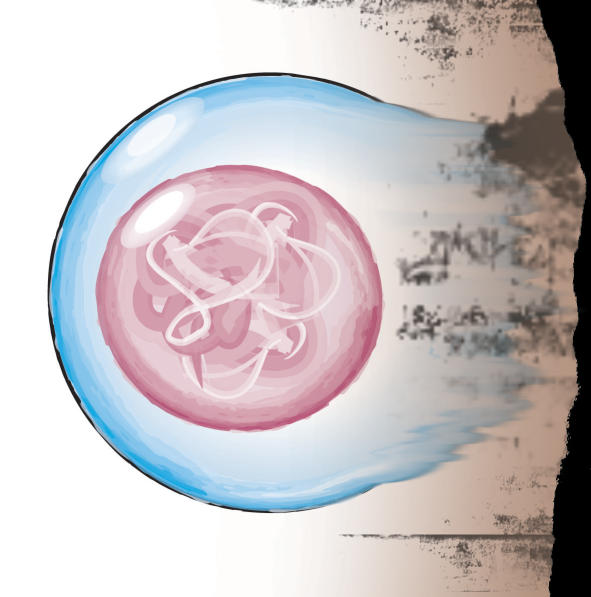
Aging HSCs exhibit a functional decline (yet an increase in cell number) and display a heightened stress and inflammatory response along with signs of epigenetic erosion.(Image: S. M. Chambers)